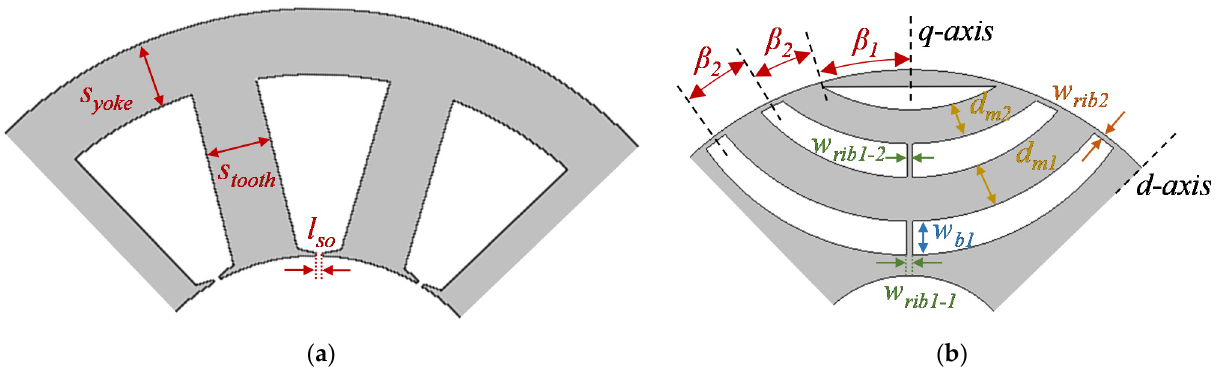
Figure 10. Design parameters to be optimized. ( a ) Stator part. ( b ) Rotor part. Table 2. Design Parameters and Their Variation Levels.